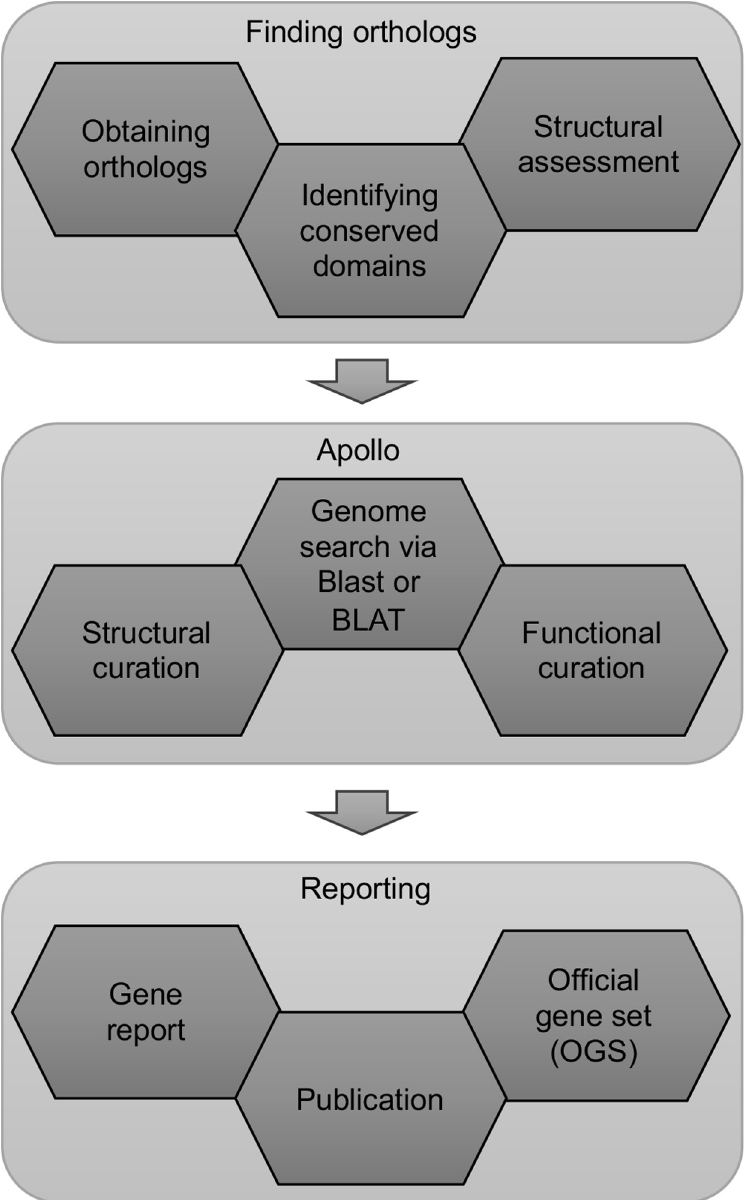
Fig 1. Annotation workflow describing various steps in manual curation of protein-coding